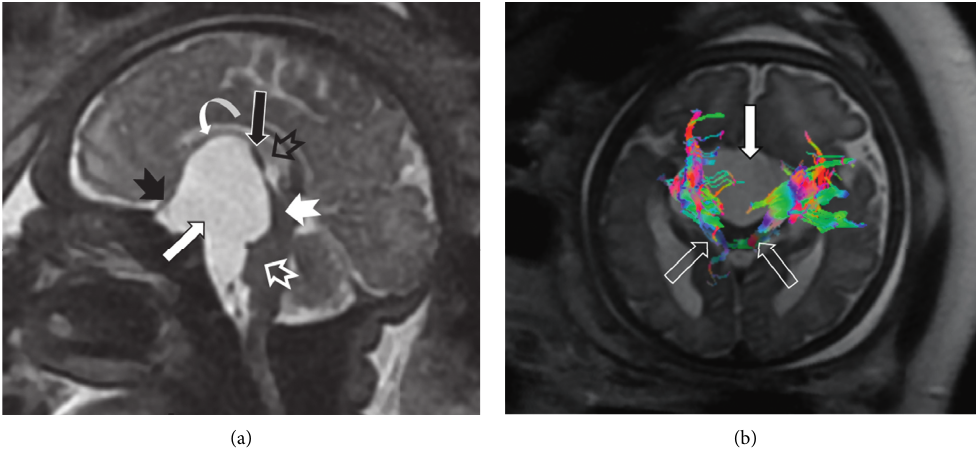
Figure 4: Arachnoid cyst associated with persistence of Liliequist membrane. Gestational age: 36 weeks and 2 days. (a) Sagittal SSFSE T2. Large-sized arachnoid cyst (solid white arrow) anterior to the mesencephalon extending into the prepontine cistern and suprasellar region is shown. The cyst produces a slight mass effect of the protuberance (empty white arrowhead) and an important mass effect on the mesencephalon (solid white arrowhead), hypothalamic region (empty black arrowhead), mammillary bodies (solid black arrow), the floor of the third ventricle (curved white arrow), and optic chiasm (solid black arrowhead). (b) Diffusion tensor with axial tractography image. The cyst (solid white arrow) extends towards the interpeduncular cistern of the mesencephalon and displaces the corticospinal tracts in a posterolateral direction (empty white arrows). Fetal MRI provides additional information because the real extent of the lesion is better evaluated than with ultrasound.